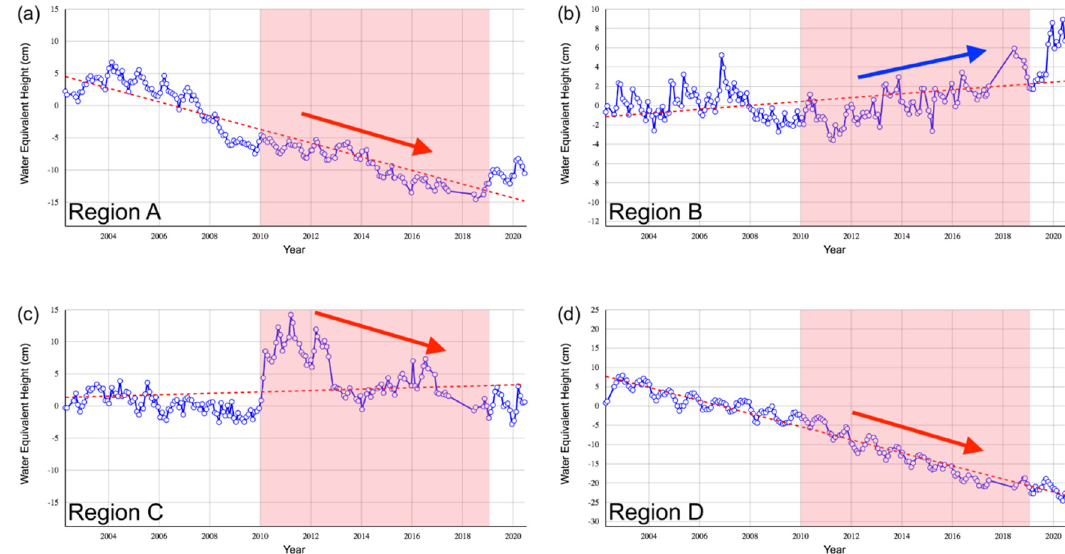
Figure 8. The GRACE Water Equivalent Height (cm) of time series for regions in Figure 7: ( a ) Region A; ( b ) Region B; ( c ) Region C and ( d ) Region D from 2002 to 2020, with pink areas covering 2010 to 2019. The blue dotted line are the observations; red dotted line is the regression line; the red/blue arrows indicate decreasing / increasing trends over the period of 2010–2019, respectively. Source: https://ccar.colorado.edu/grace/jpl.html.